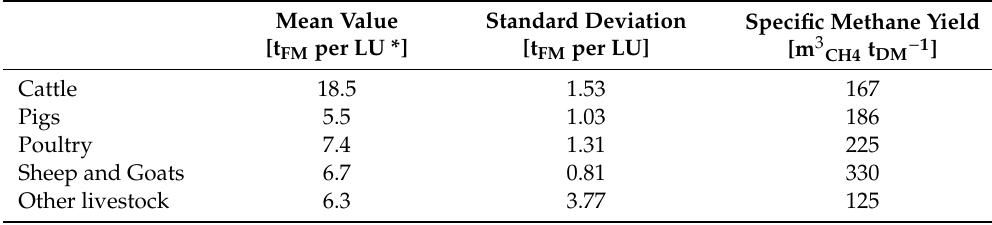
Table 2. Mean value and standard deviation for the amount of farm manure in tons of fresh matter per livestock unit (LU) and the specific methane yield in cubic meters of methane per ton of dry matter